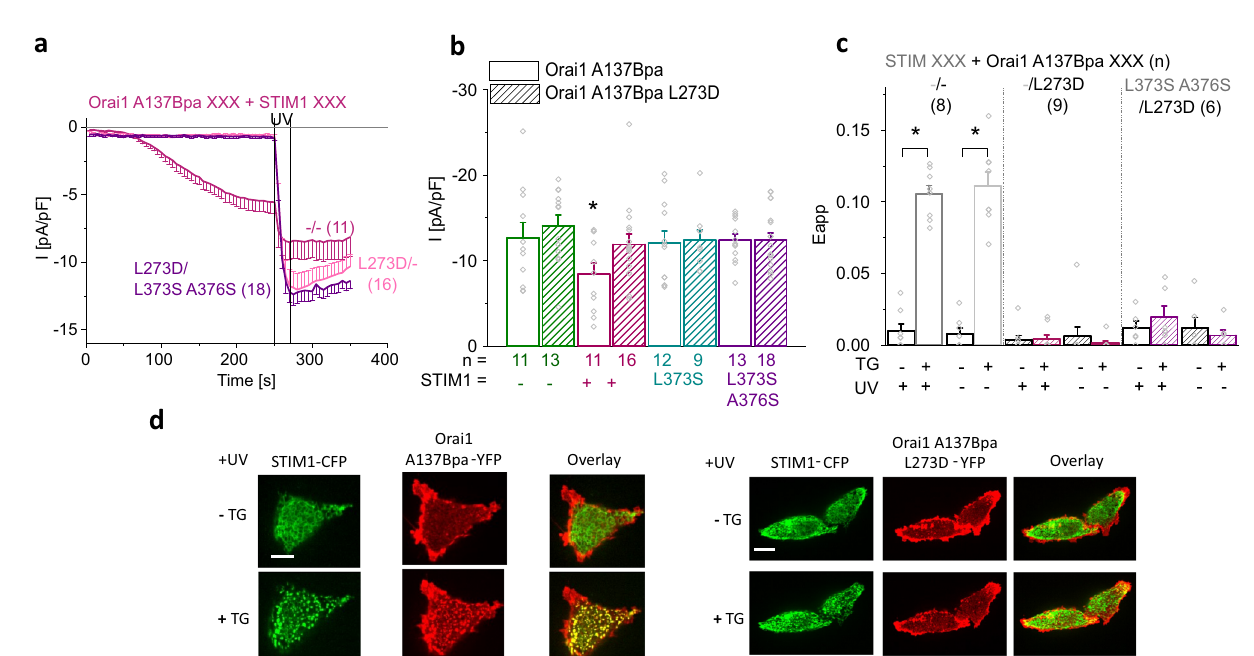
Fig. 4 | STIM1 is not required for UV-mediated activation of photocrosslinking UAA-containing Orai1 mutants. a Time courses of current densities after whole- cell break-in of Orai1 A137Bpa or Orai1 A137Bpa L273D co-expressed with either STIM1 or STIM1 L373S A376S. UV light is applied for 15s att=250s, the time point after maximum STIM1-mediated Orai1 mutant activation indicating completed store-depletion. b Bar diagram summarizes UV-induced maximum currents mea- sured for Orai1 A137Bpa or Orai1 A137Bpa L273D in the absence of STIM1 or the presenceof STIM1, STIM1 L373SorSTIM1 L373S A376S. Single values are indicated in gray (one-way ANOVA for ( b ): F(7;99)=2,15, p =0.046). c Bar diagram of FRET (E app ) comparing STIM1 or STIM1 L373SA376S co-expressedwithOrai1A137Bpa